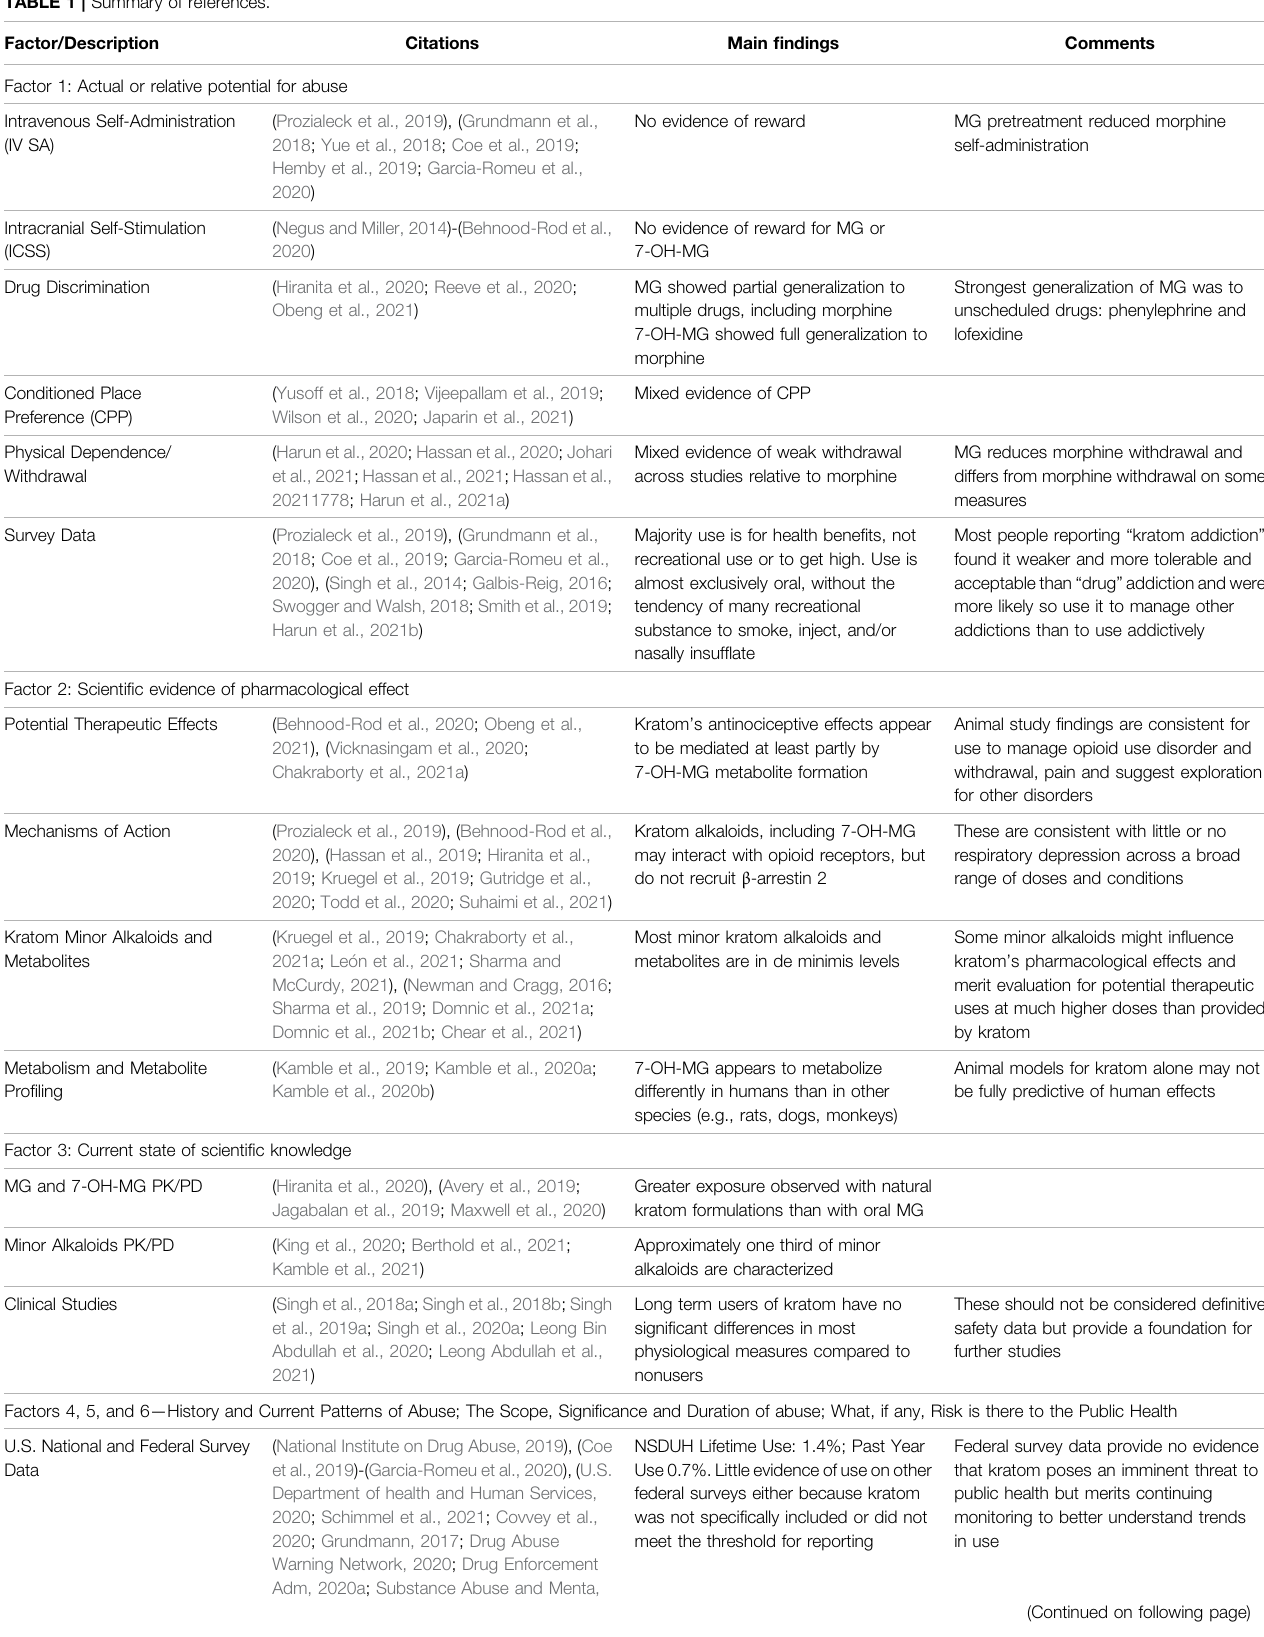
TABLE 1 | Summary of